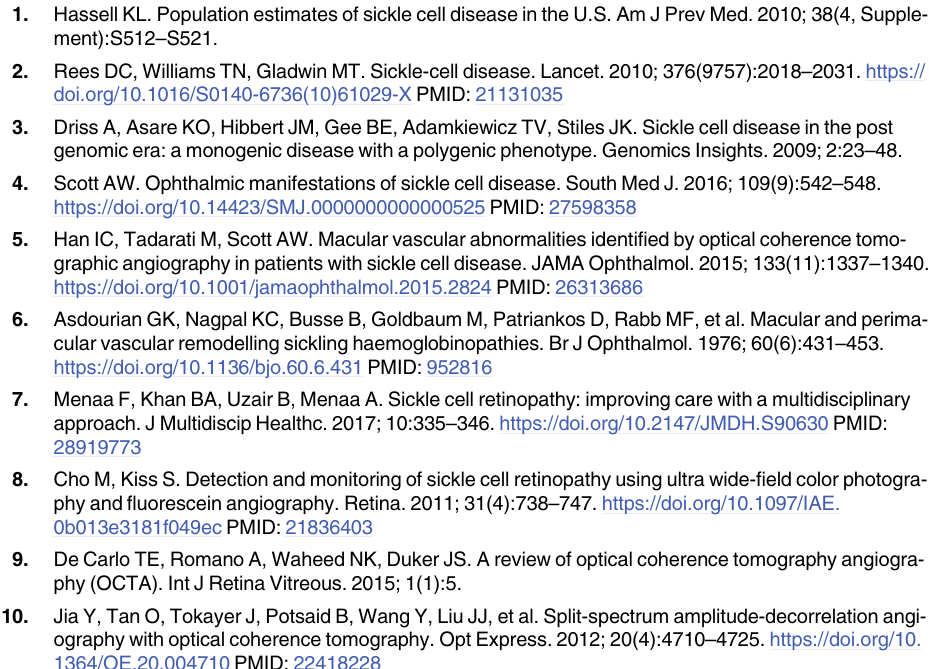
S1 Table. Interocular asymmetry analysis